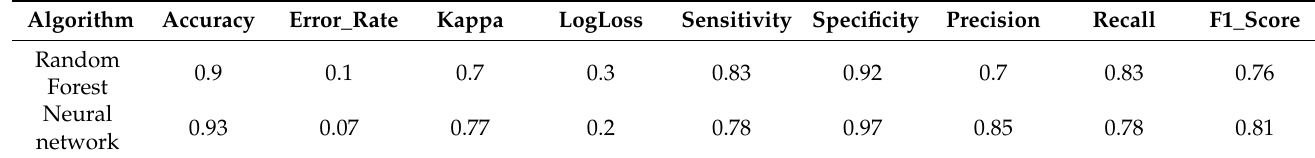
Table 15. Models for city of Perth.